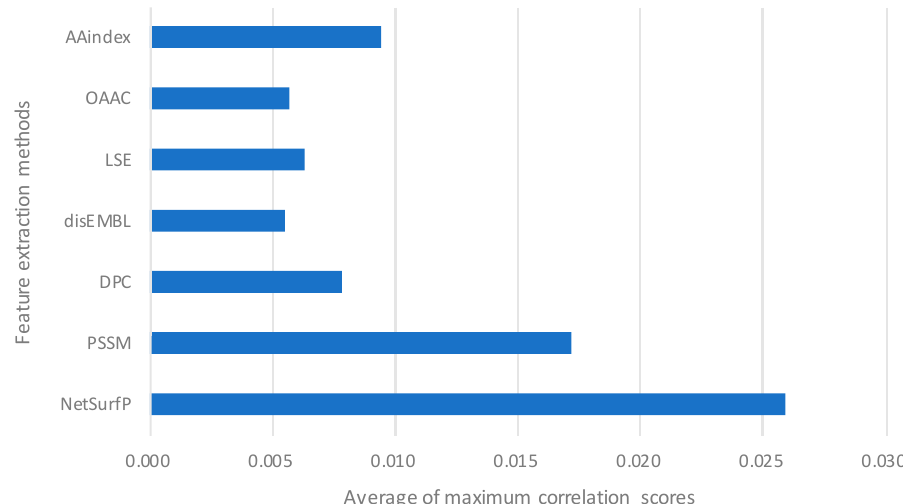
Figure 4. The top five maximum correlation scores of features obtained by different feature extraction methods were calculated.